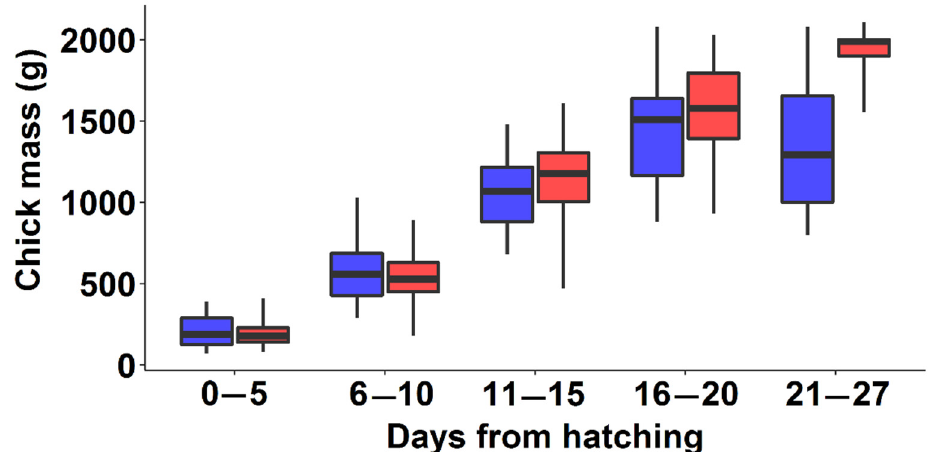
Figure 8. Observed chick mass (grams) within arbitrarily-defined periods spanning hatching to late guard stage in the two study colonies (blue: AdCo; red: EdPo). The modified boxplots show median (thick line) and range (whiskers) of observed values.